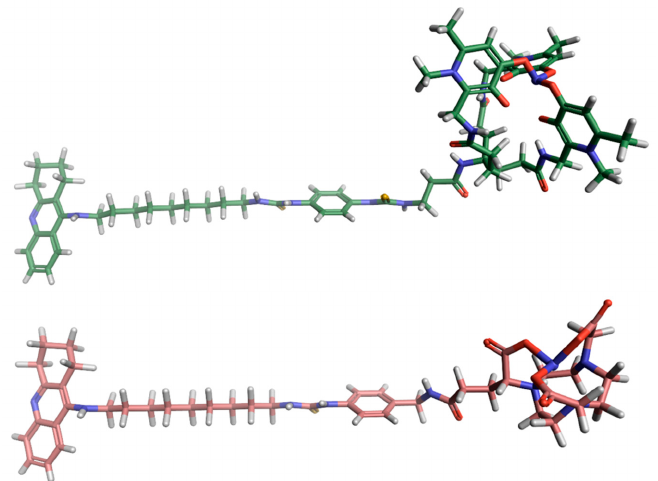
Figure 7. Three ‐ dimensional structures of Ga ‐ THP ‐ NH(CH 2 ) 9 Tac ( top ) and Ga ‐ NODAGA ‐ Bn ‐ NH(CH 2 ) 9 Tac ( bottom ) compounds, calculated at the DFT level of theory. Note, that tacrine and the nonamethylene chain are identical for both compounds, while the linkers, i.e., thiourea ‐ phenyl ‐ thiourea in Ga ‐ THP ‐ NH(CH 2 ) 9 Tac and thiourea ‐ phenyl in Ga ‐ NODAGA ‐ Bn ‐ NH(CH 2 ) 9 Tac, as well as chelators, i.e., THP in Ga ‐ THP ‐ NH(CH 2 ) 9 Tac and NODAGA in Ga ‐ NODAGA ‐ Bn ‐ NH(CH 2 ) 9 Tac, are different. Results of the in silico docking experiments of Ga ‐ THP ‐ NH(CH 2 ) 9 Tac and Ga ‐ NODAGA ‐ Bn ‐ NH(CH 2 ) 9 Tac compounds to the crystallographic structure of human acetylcholinesterase (hAChE) are presented in Figure 8.